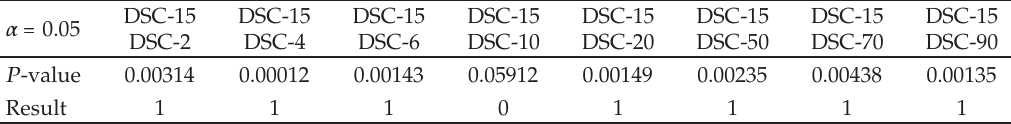
Table 2: Result of t -tests for the paired comparison of the default social